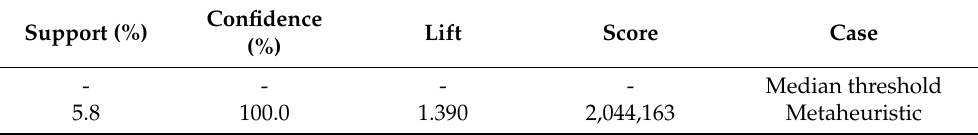
Table 6. Optimization results for all (presented in Table 2) criteria considered as the